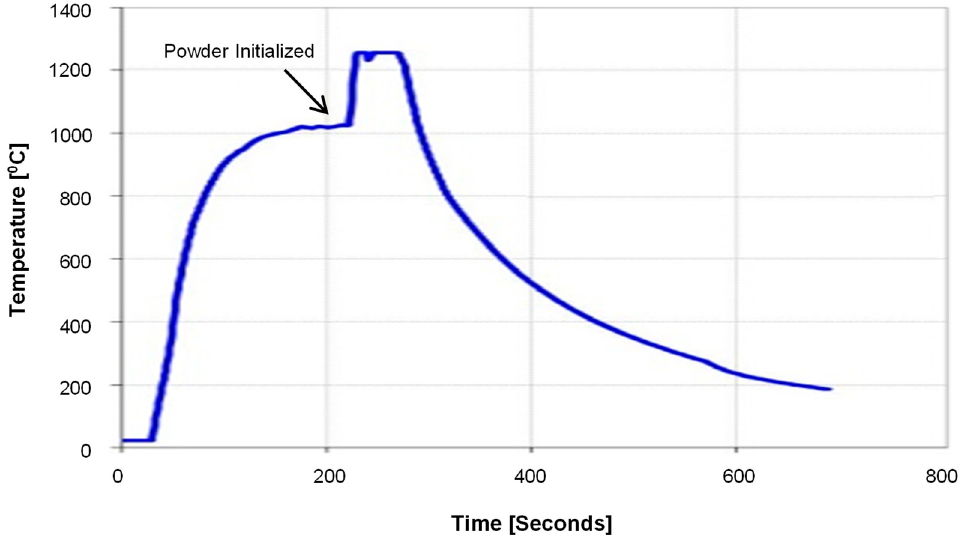
Figure 4. Temperature measurement on back side of a stainless steel plate preheated by gases from the oxyacetylene torch, followed by injection of aluminum powder.